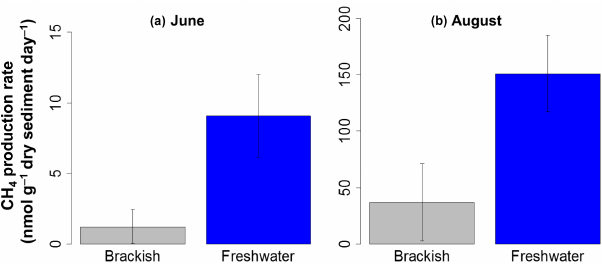
Figure 3. Mean CH 4 production rates (nmolg − 1 dry sedi- mentday − 1 ) from Copper River delta non-tidal freshwater ( n = 9) and tidal brackish ( n = 5) wetlands during (a) June and (b) Au- gust 2014. Error bars represent standard